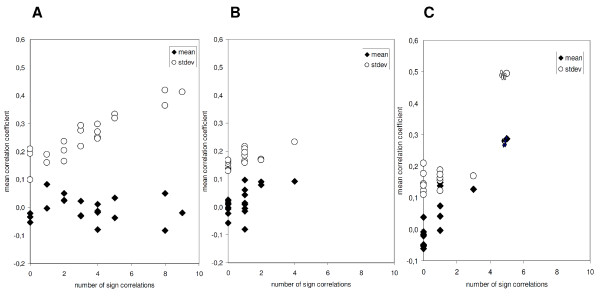
Number of correlation coefficients with significance in relation to mean and standard deviation of all coefficients per variable. 3A: 20 markers of the cell infiltrate underneath the scar with mean and standard deviation of all 19 correlation coefficients of every variable in relation to the number of significant correlations per variable. A standard deviation of more than 0.2 indicated highly cross-linked marker proteins, whereas the mean of all coefficients did not. 3B: 20 variables in a fictive model of random figures with mean and standard deviation of all 19 correlation coefficients of every variable in relation to the number of significant correlations per variable. With means between +0.1 and -0.1 and standard deviations of less than 0.25 highly cross-linked variables were rare. 3C: 20 variables in a fictive model of random figures after introduction of a cross-linked cluster with mean and standard deviation of all 19 correlation coefficients of every variable in relation to the number of significant correlations per variable. A standard deviation of more than 0.2 indicated highly cross-linked variables.